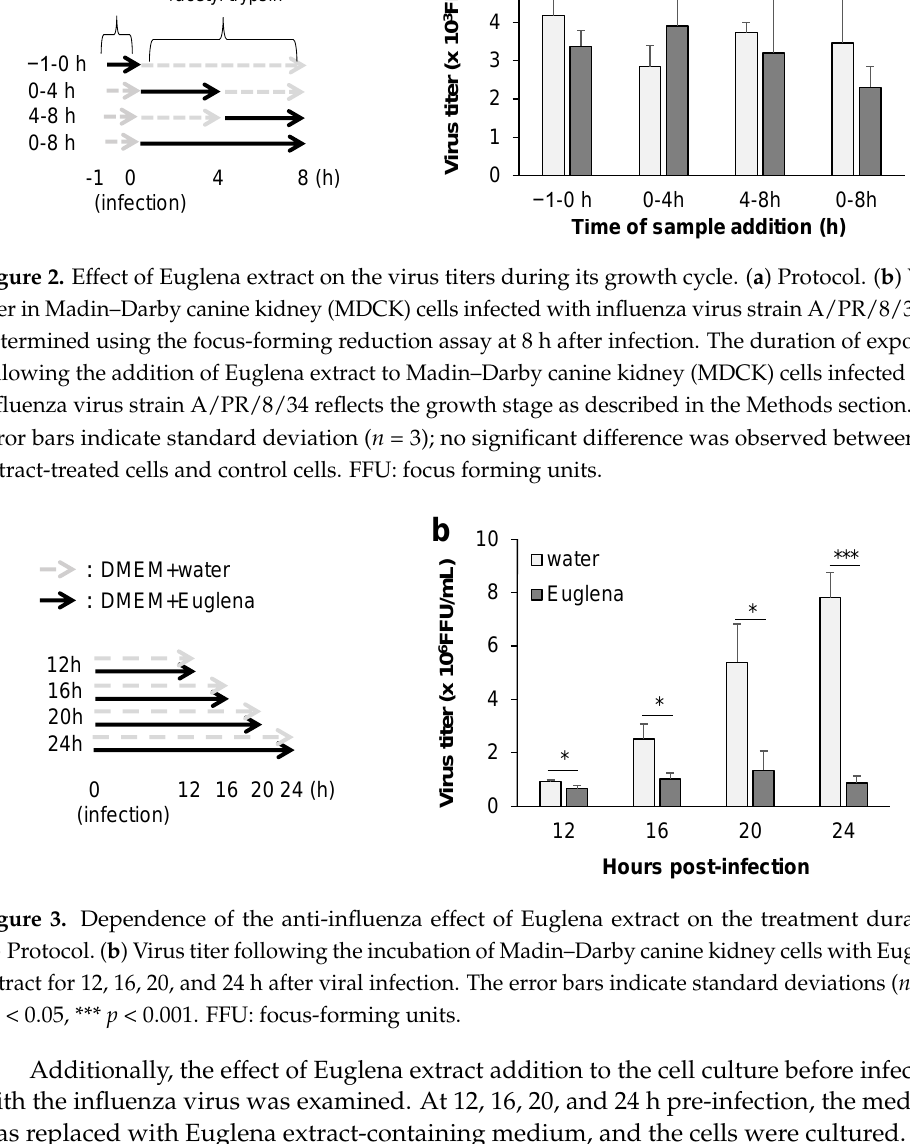
Figure 2. Effect of Euglena extract on the virus titers during its growth cycle. ( a ) Protocol. ( b ) Viral titer in Madin – Darby canine kidney (MDCK) cells infected with influenza virus strain A/PR/8/34, as determined using the focus-forming reduction assay at 8 h after infection . The duration of expo- sure following the addition of Euglena extract to Madin – Darby canine kidney (MDCK) cells infected with influenza virus strain A/PR/8/34 reflects the growth stage as described in the Methods section. The error bars indicate standard deviation ( n = 3); no significant difference was observed between the extract-treated cells and control cells. FFU: focus forming units.